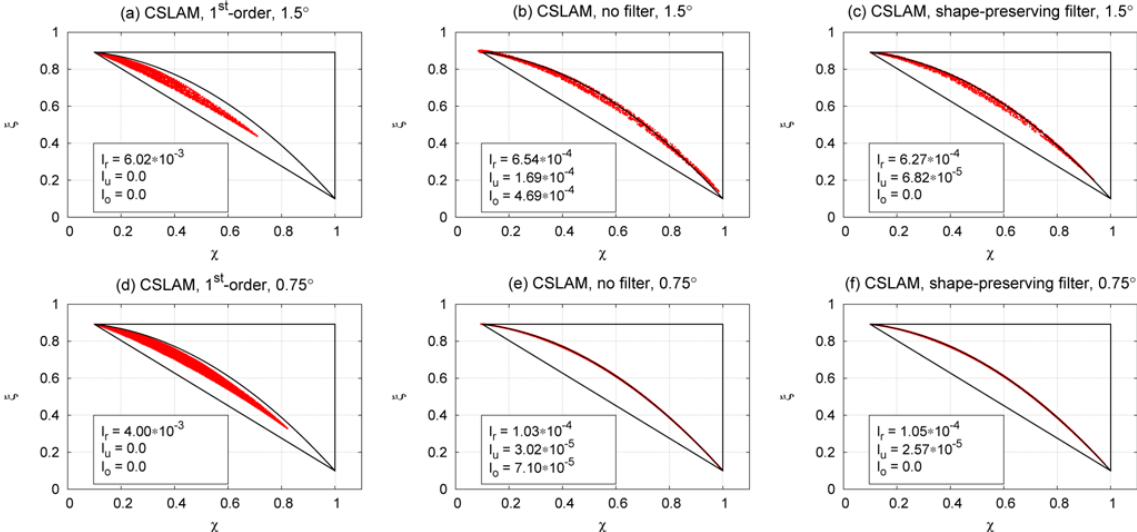
Fig. 8. Scatter plots at t = T/ 2 for two non-linearly correlated species/tracers based on cosine bells initial conditions using first-order version of CSLAM ( a and d ), standard CSLAM based on bi-parabolic reconstruction functions ( b and e ) and standard CSLAM with a shape- preserving filter ( c and f ). First and second row use 1λ = 1 . 5 ◦ and 1λ = 0 . 75 ◦ resolutions, respectively. The solid lines mark the boundaries between the areas used to classify the numerical mixing. On each plot the mixing diagnostics ‘ r , ‘ u and ‘ o are given.